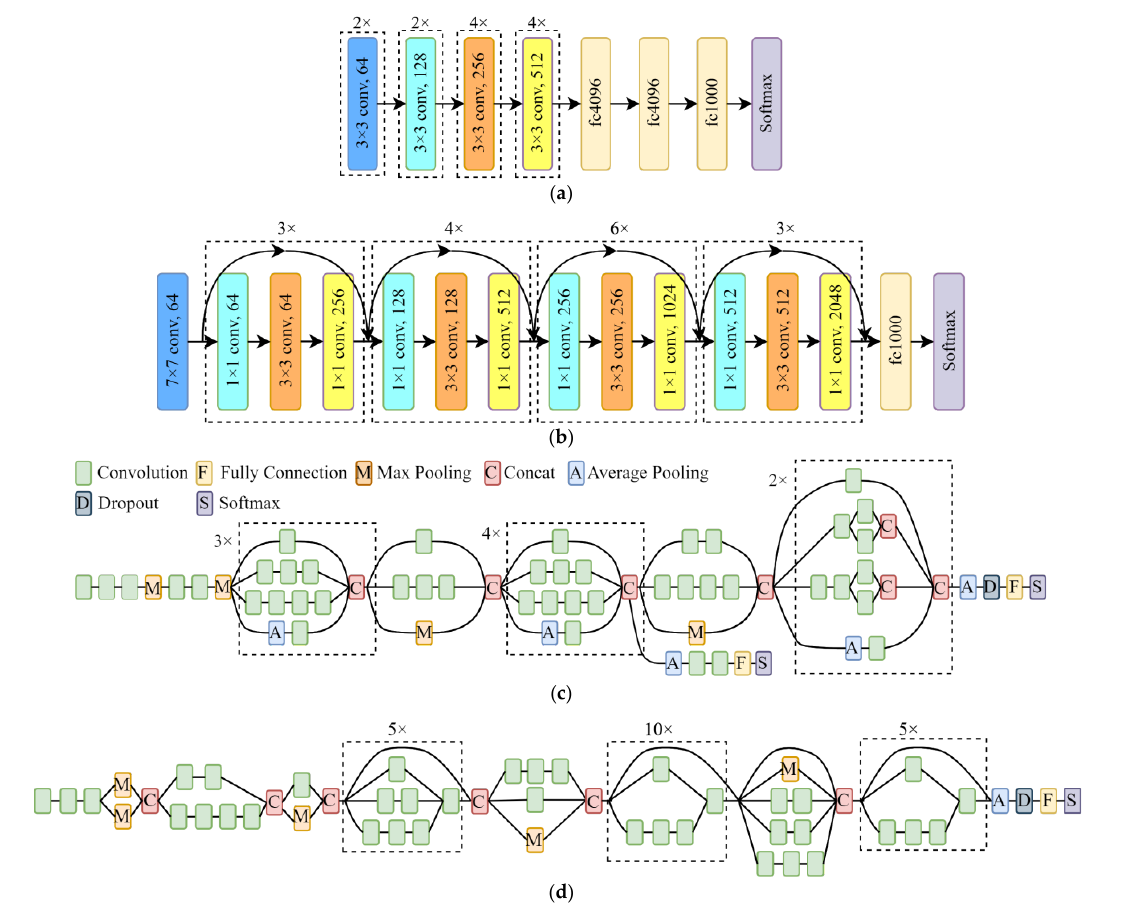
Figure 5. Architectures of typical deep neural networks. ( a ) VGG19; ( b ) ResNet50; ( c ) InceptionV3; ( d ) InceptionResNetV2. Table 1. The parameter information regarding network models.